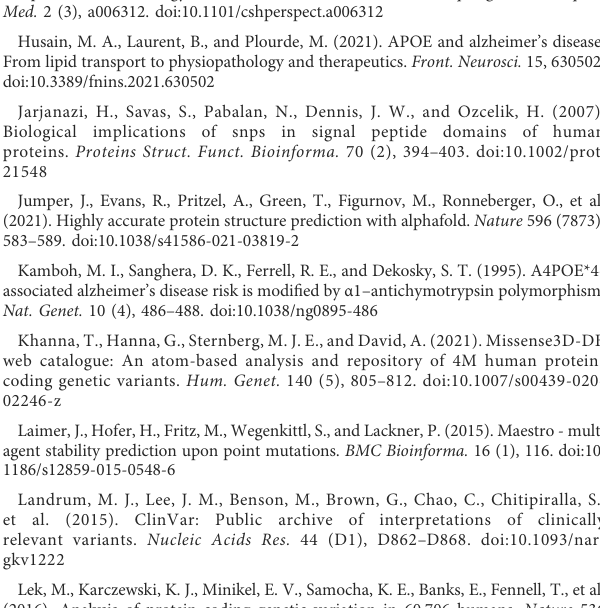
SUPPLEMENTARY FIGURE S1 Performances of all quantitative predictors analyzed in this study benchmarked using ClinVar labels. The dashed red line represents the ROC cut-off value. Tools with greater ROC values were chosen to construct the ensemble. SUPPLEMENTARY FIGURE S2 ROC curves for all quantitative predictors analyzed in this study benchmarked using ClinVar